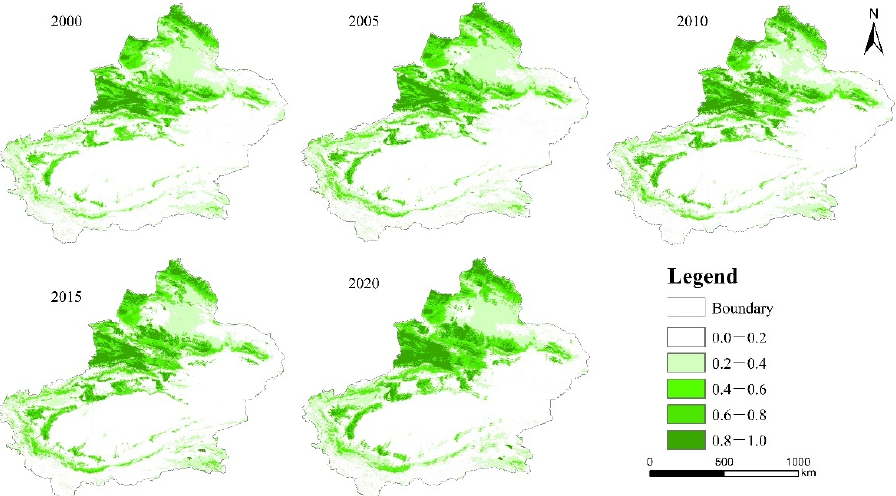
Figure 6. Distribution characteristics of the spatial variation of NDVI in Xinjiang from 2000 to 2020.